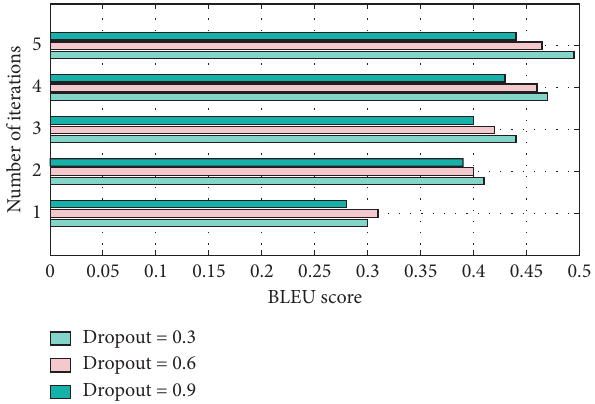
Figure 7: Comparison of BLEU scores under different dropouts.